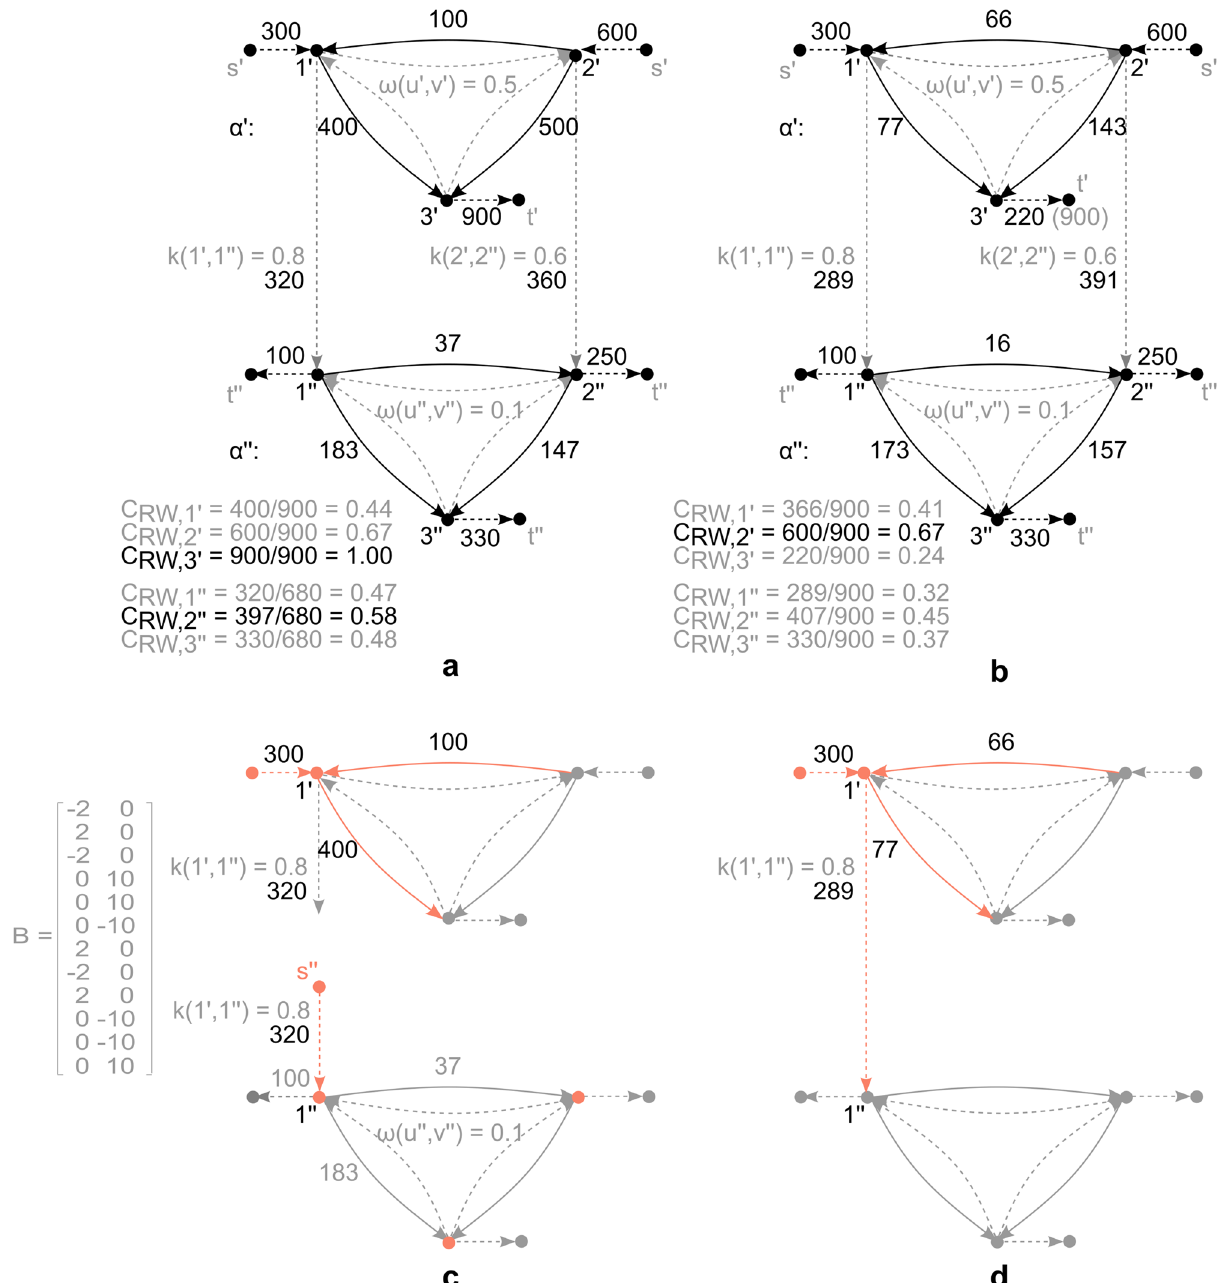
Figure 3. Simplified illustration of multilayer network flow derivation. ( a ) Illustrative multilayer flow network, comprising of two layers α ′ , α ′′ , single-source s ′ and single-sinks t ′ , t ′′ , where intra-layer flow is determined by arc weights ω ′ , ω ′′ , while inter-layer flow conversion is determined by conversion coefficient k . Multilayer network flow is derived as heterogeneous network flow , based on the proposed framework. The figure depicts, furthermore, the corresponding flow based random walk node betweenness centrality C RW 44 , derived as node flow throughput, normalized by maximum st -flow (note that the measure is a function of network flow). Highest centrality denotes node(s) with highest impact, importance or influence. ( b ) Multilayer network flow derived as a simple mono- semantic random walk, based on 46 . The figure depicts, furthermore, derivation of corresponding flow based random walk centrality C RW 44 , as proposed in 46 . By comparative analysis (panel a and b) a different network flow is observed. The difference is reflected in node centrality (highest impact/importance) as well, where removal of the highest centrality node in the first network (panel a: node 3 ′ in layer α ′ ), would result in a collapse of the entire network, given removal of the only sink (demand) node in layer α ′ (reducing all flows to 0, due to flow balance and coupling constraints). In the second network (panel b), however, the removal of the highest centrality node would only result in a flow rebalance, not reflecting the true coupling nature of the underlying evolution process. ( c ) Flow conservation and coupling (as satisfied by the proposed framework in panel a), where inter-layer coupling does not participate in conservation of flow of the source layer. The coupling acts as exogenous flow with respect to the sink layer, influencing, along with network topology, the respective node potentials. The panel contains also an example of basis matrix B corresponding to the network in panel a. ( d ) Flow conservation (and coupling) inconsistent (violated), for simple mono-semantic random walk approach to multimodal flow derivation in panel b (note that arc ( 1 ′ , 1 ′′ ) is an inter-layer arc, where incident end nodes correspond to different layer